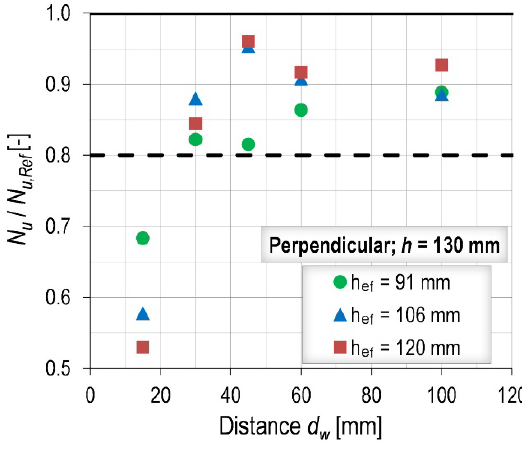
Figure 10. Numerical results of Series 2 .